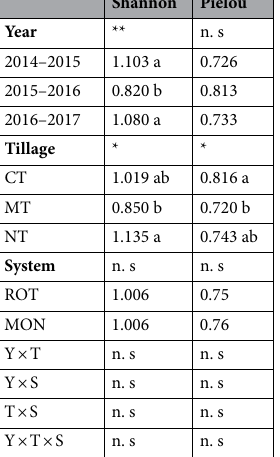
Capsella bursa- Anacyclus clavatus pastoris Cardaria draba Fumaria spp. Galium spp. Hypecoum spp. Papaver spp.